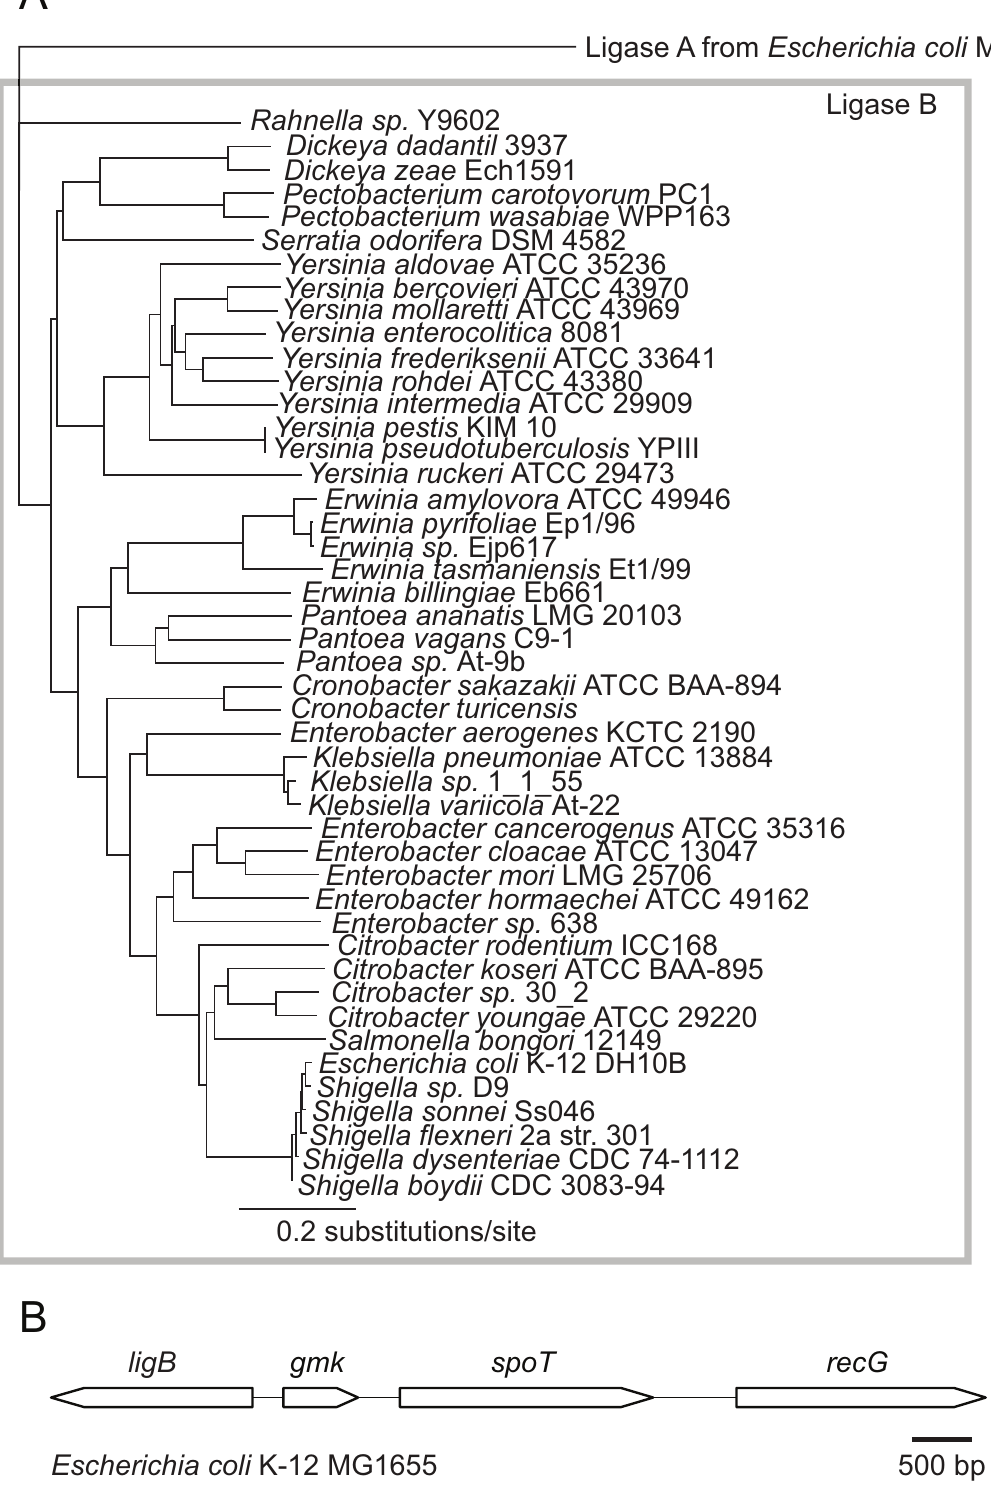
Fig 1. E . coli ligase B. (A) Ligase B amino acid sequencesimilarity tree. LigaseB peptidesequencesfrom 46 species of Enterobacteriaceae are shown comparedto the outgroup,ligase A. The distanceof 0.2 substitutionsper site is indicated. (B) The conserved ligB gene neighborhood (S2 Fig), represented by the regionin E . coli